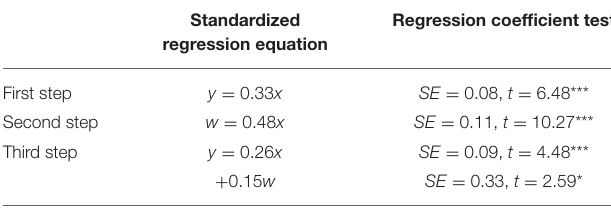
TABLE 3 | Examination of the mediating effect of exercise identification (W).